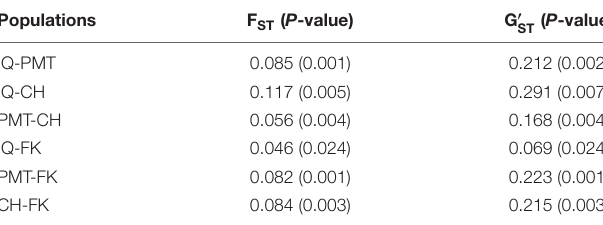
TABLE 5 | Pairwise, populations level estimates of genetic differentiation (F ST and G (cid:48) ST ) for Patagonian toothfish